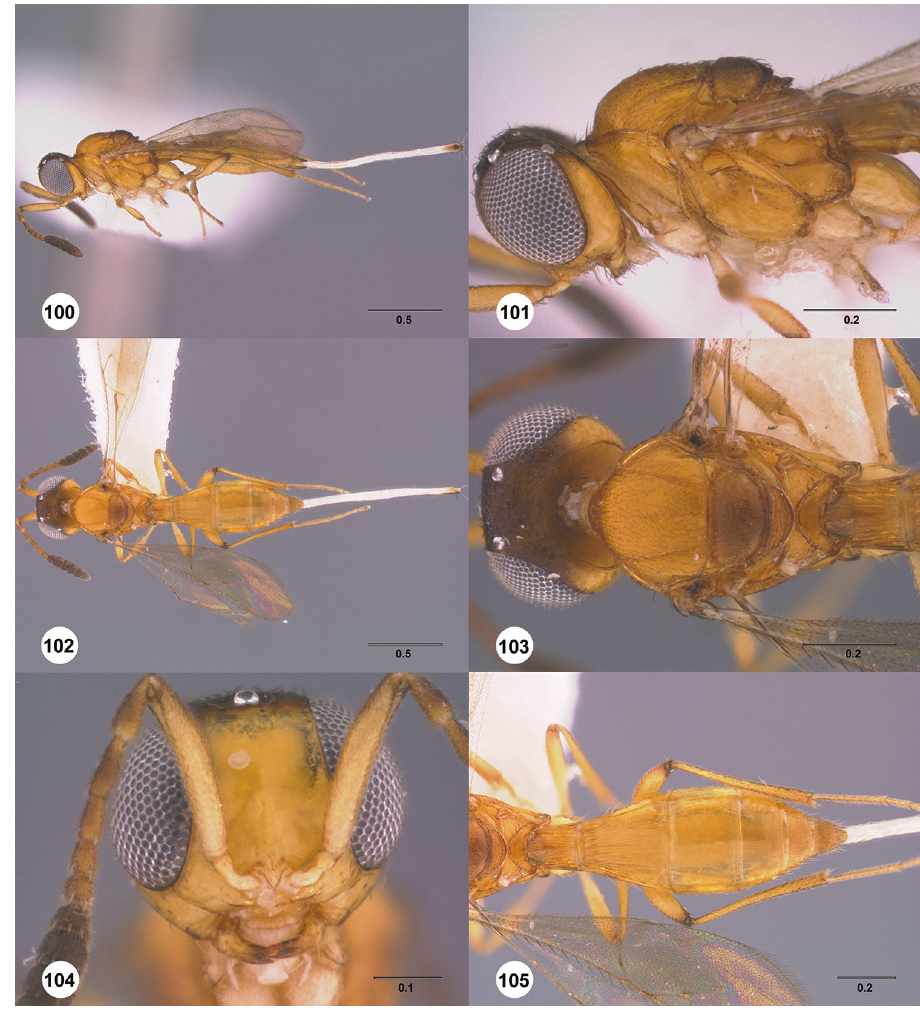
Figures 100–105. Calliscelio extenuatus sp. n., female, holotype (OSUC 48454). 100 Lateral habitus 101 Head and mesosoma, lateral view 102 Dorsal habitus 103 Head and mesosoma, dorsal view 104 Head, anterior view 105 Metasoma, dorsal view. Scale bars in millimeters. Color of fore wing: hyaline. Rs+M: nebulose, weakly pigmented. Setae on R: long, erect, surpassing the margin of the wing. Length of R: distinctly shorter than r-rs. Length of R1: greater than 3.0× length of r-rs. Color of metasoma in female: orange throughout; variably orange to pale brown; yellow throughout. Horn on T1 in female: absent. Sculpture of posterior margin of T1 in female: longitudinally striate throughout. Development of longitudinal striae on T2 in female: reaching the middle of T2 medially; reaching posterior margin of